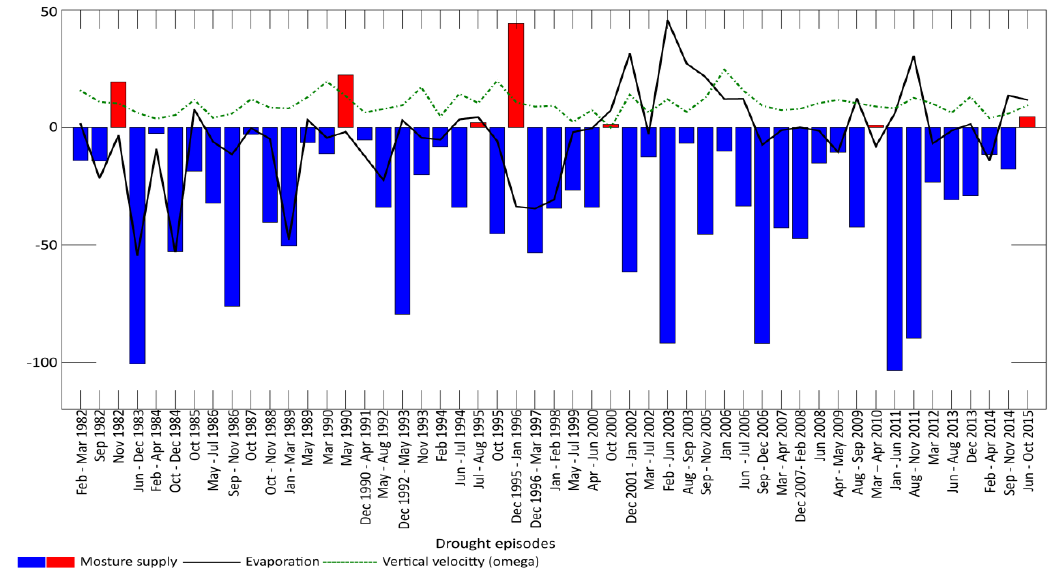
Figure 4. Monthly anomalies of the evaporation rate over the MDS (*10 mm/day, black line), the vertical velocity (omega) at 500 hPa (/1000 Pa/s, green line) and the moisture supply from the MDS (mm/day, blue and red bars) accumulated during each meteorological drought episode identified over the CEU during the period 1980–2015.